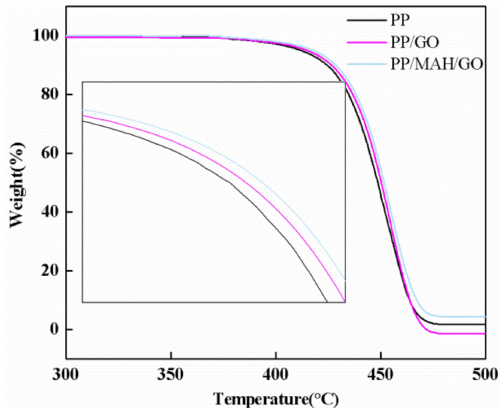
Figure 5. TGA image of composite